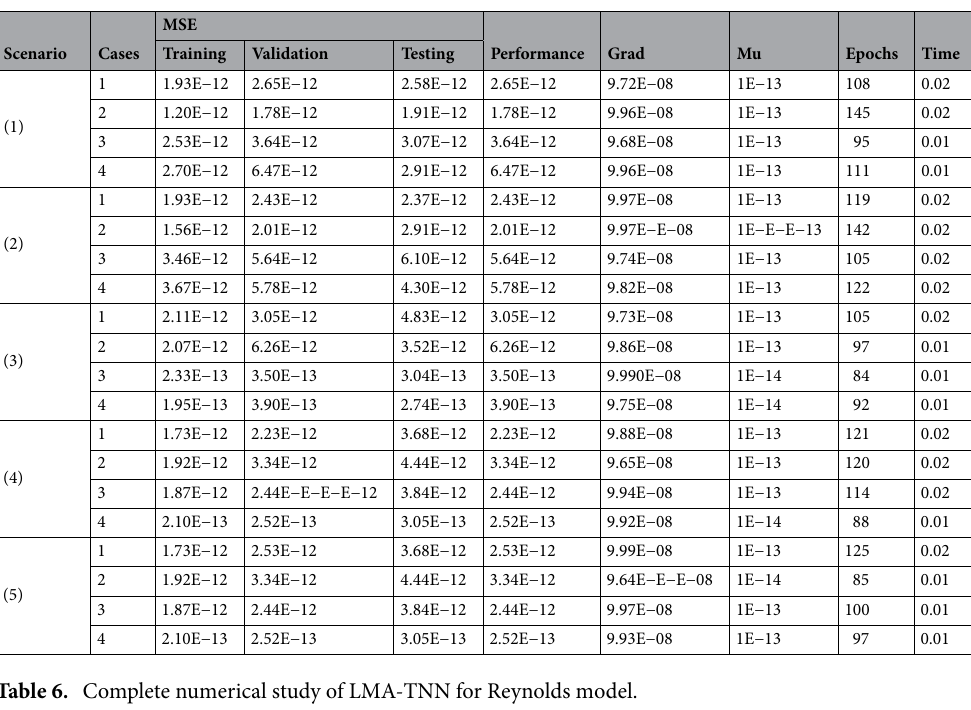
Table 6. Complete numerical study of LMA-TNN for Reynolds model.